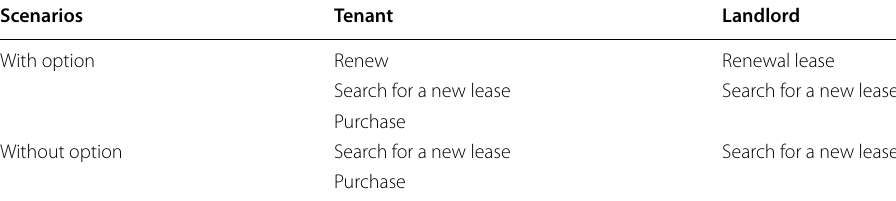
Table 2 Potential scenarios for counterparties at lease expiration